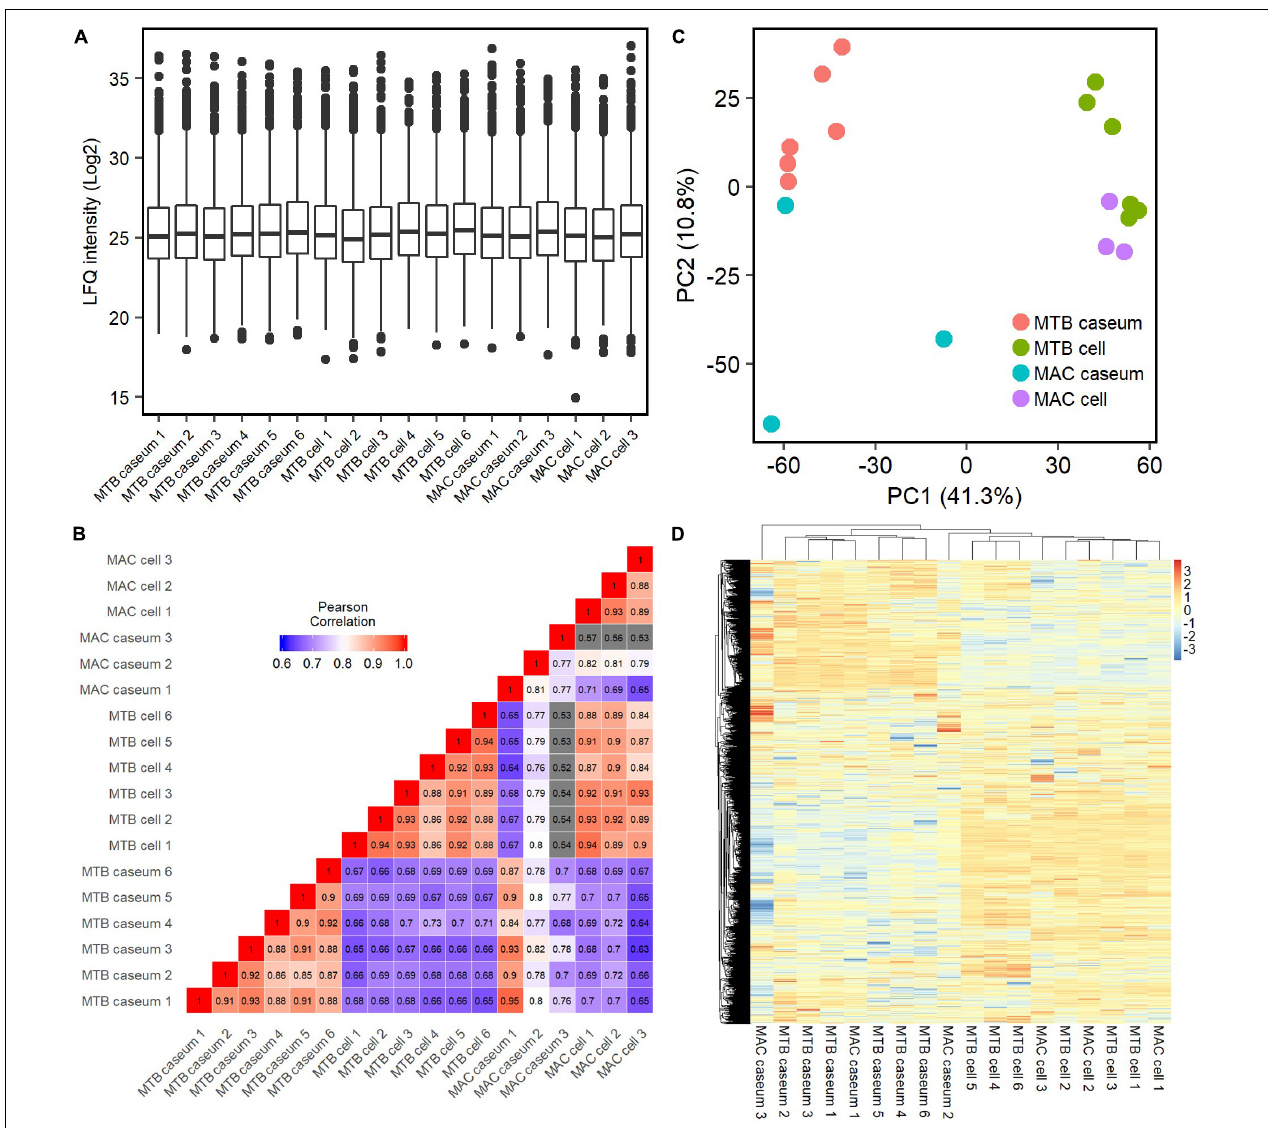
FIGURE 2 | Quantitative profiling of identified proteins in granulomatous sub-compartments. (A) Boxplot of LFQ intensity values of identified proteins in the samples. Log 2 -transformed LFQ intensity values of identified proteins in each sample are shown. Bold lines indicate the median of log 2 -transformed LFQ intensity values, a box captures 50% of the measurements, and whiskers span values of the 5–95% interval. Outliers are shown as dots. (B) Heatmap of Pearson correlation coefficient (PCC) matrix of all samples. The values of PCC were generated using the log 2 -transformed LFQ values from all pairwise correlation among the samples. Coefficient numbers are also indicated. (C) Principal component analysis (PCA) of all samples based on LFQ intensity values. The first two main components, PC1 and PC2, accounting for 41.3 and 10.8% of data variability from all samples, are used for the plot. (D) Hierarchical-clustering-based heatmap for identified proteins between granulomatous sub-compartments ( n =